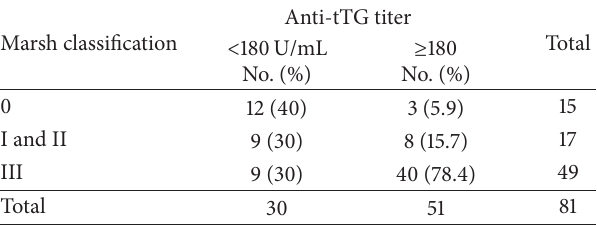
Table 2: Marsh classification and anti-tTG titer cross tabulation. Marsh